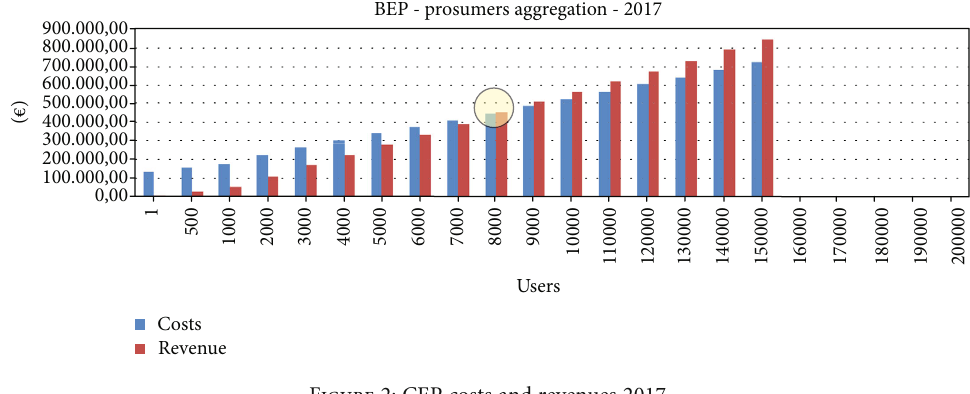
Figure 2: CEP costs and revenues 2017. Table 9: Yearly electricity bill 2016 vs. 2017 for the end-user not aggregated and aggregated .